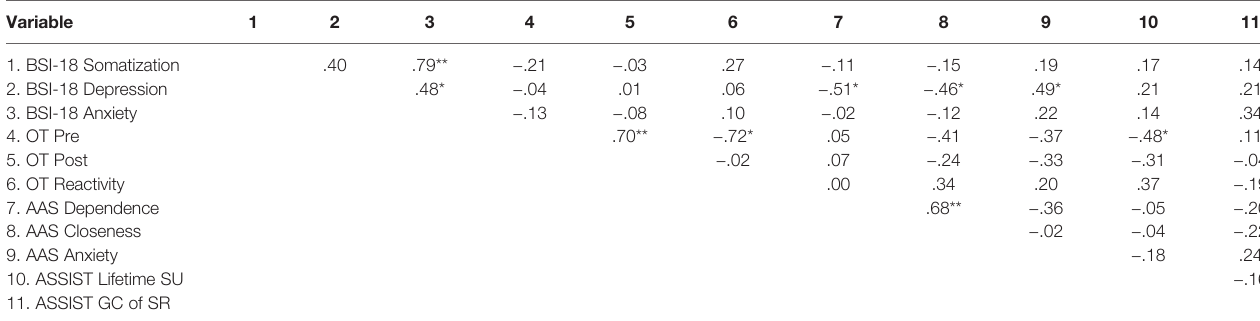
TABLE 3 | Intercorrelations for behavioral and biological measures for PUD ( n =